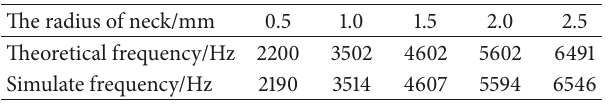
Table 1: Relation between the neck radius and resonance frequency, ( 𝑅 𝑜 = 5.0 mm, 𝑅 𝑖 = 4.5 mm).